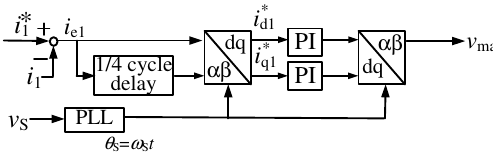
Figure 5. Control circuit diagram of single-phase current feedback control block in d - q coordinates in d - q coordinates, which was used in Figure 2.